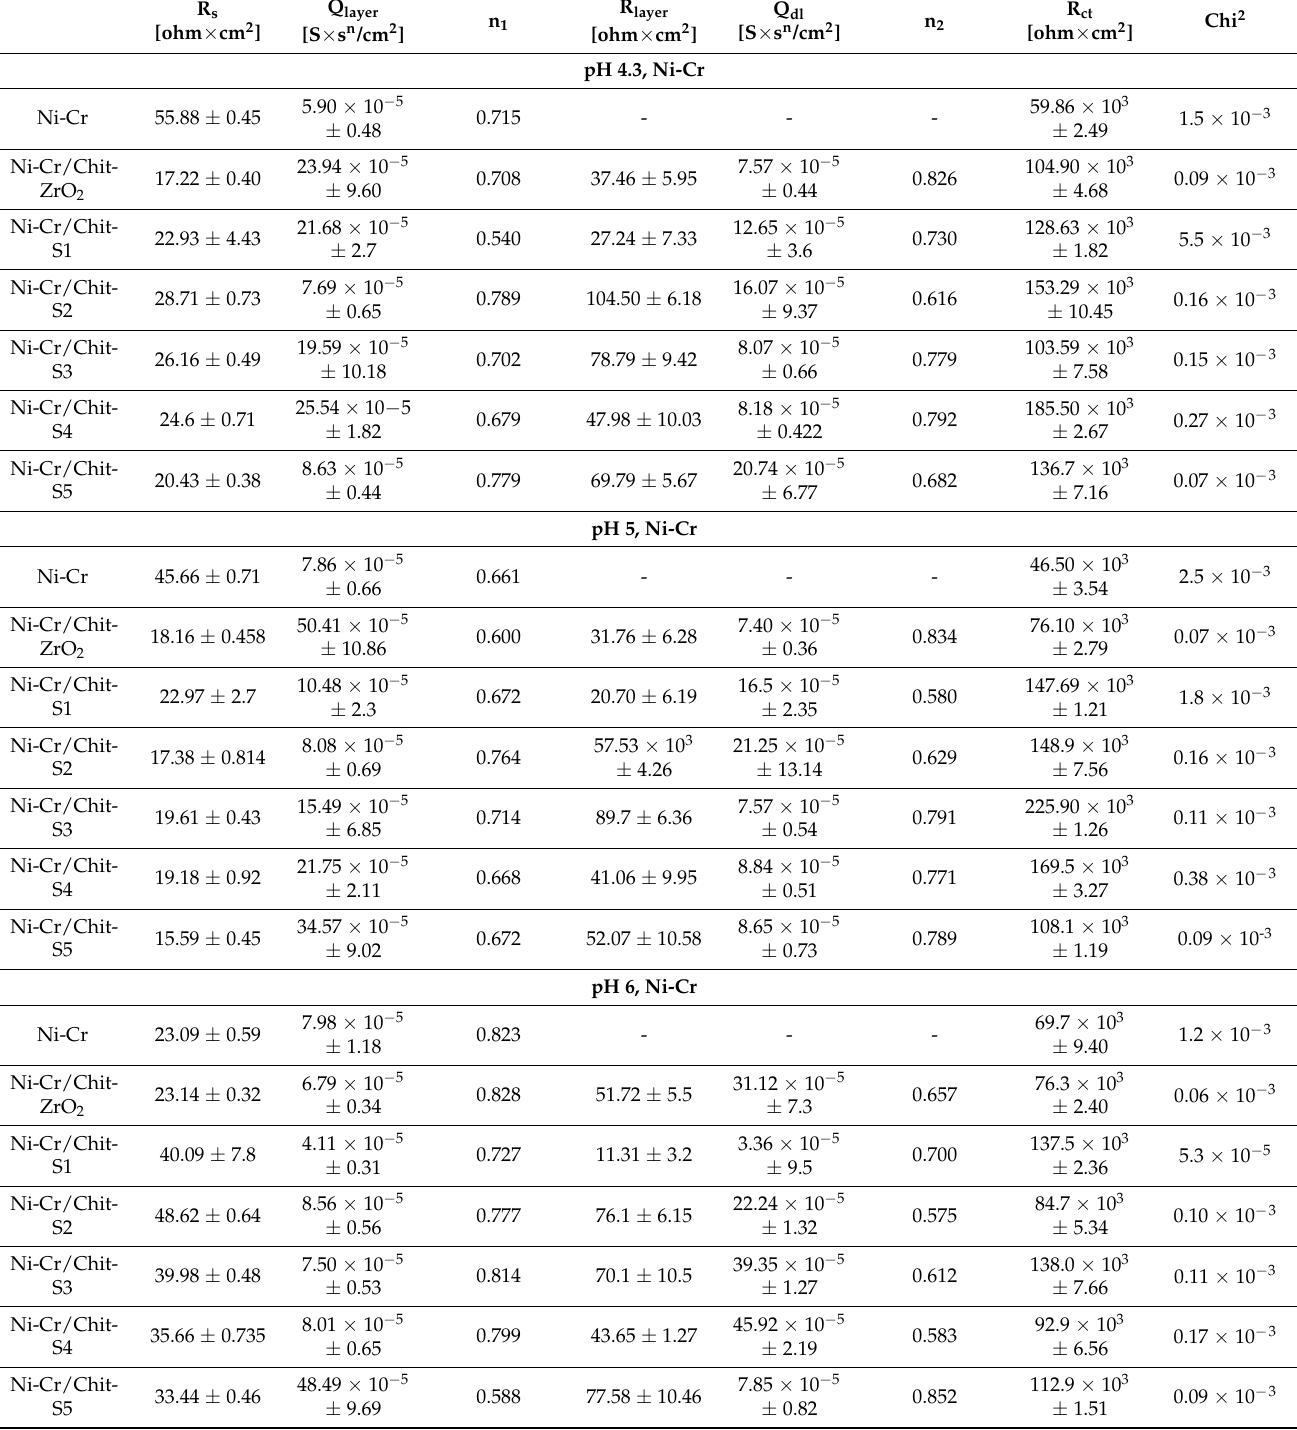
Table 2. Electrochemical impedance spectroscopy data of Ni-Cr, Ni-Cr/Chit-ZrO 2 and Ni-Cr/Chit-Sx (where x = 1-5) after immersion in artificial saliva of different pH values, using R s (Q dl R c t) or R s (Q layer R layer )(Q dl R ct ) equivalent electric circuit. Q layer R s [ohm × cm 2 ] [S × s n /cm 2